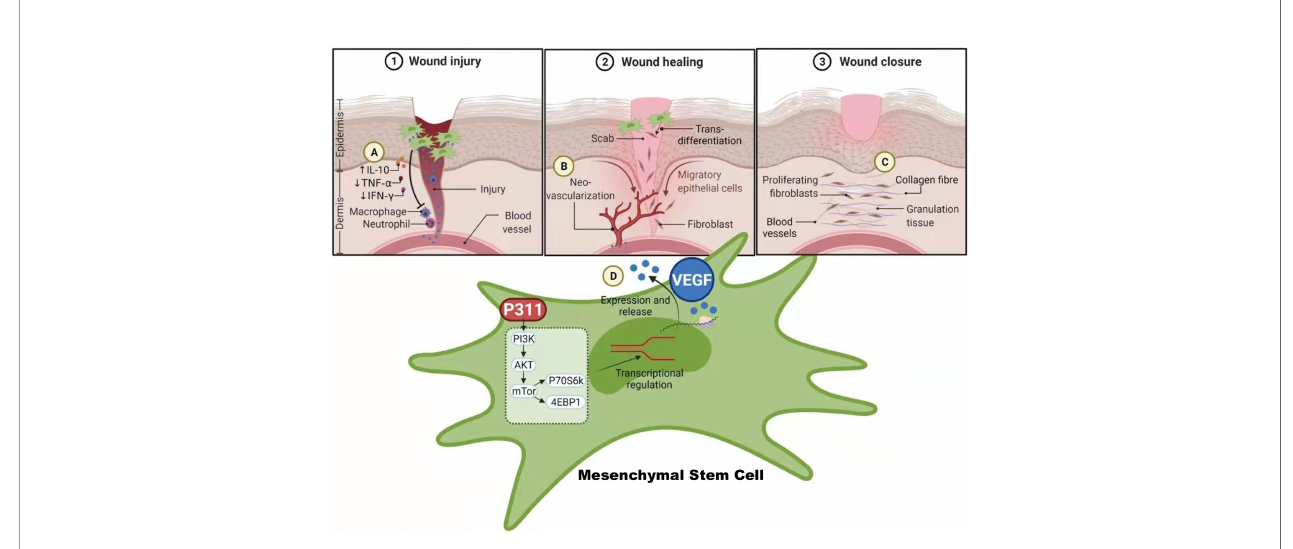
FIGURE 7 | The schematic diagram on how P311 enhances the wound healing capabilities of MSCs via the up-regulation VEGF expression mediated by mTOR signalling pathway. (A) P311-mediated anti-in fl ammatory effects attenuate the in fl ammatory status of wound tissues for wound healing. (B) Neo-vascularization of new blood vessels by the release of VEGF from MSCs with increased P311 levels that enhances their pro-angiogenesis function to accelerate skin wound healing. (C) Increased collagen deposition and elevated production of hydroxyproline by MSCs with increased P311 levels. (D) Increased P311 levels in MSC activates the mTOR signalling pathway, which in turn up-regulate the expression of VEGF, leading to their release from the MSCs to aid in enhanced wound healing process by MSCs. Collective functions of these processes mediated by P311 enhanced MSCs contributes to the overall quality of wound healing. Created with